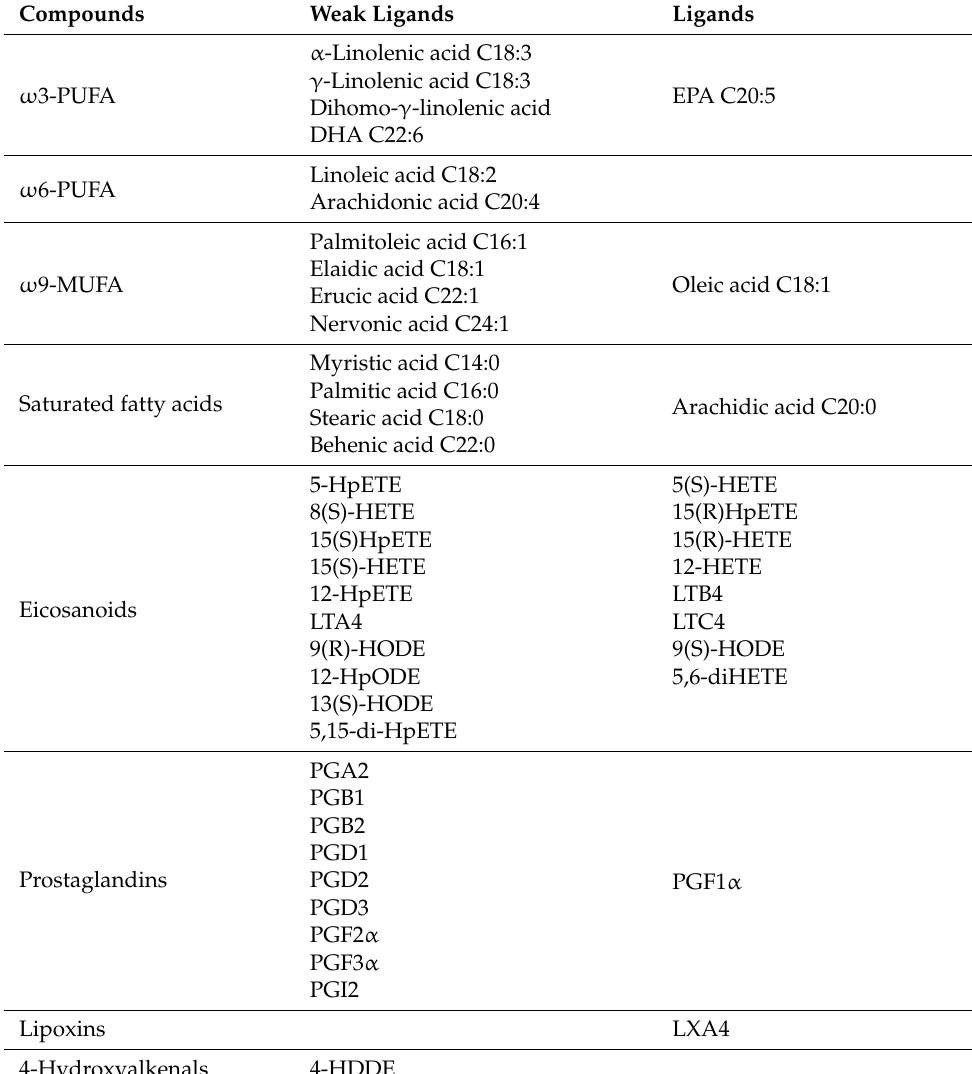
Table 1. PPAR δ potential endogenous